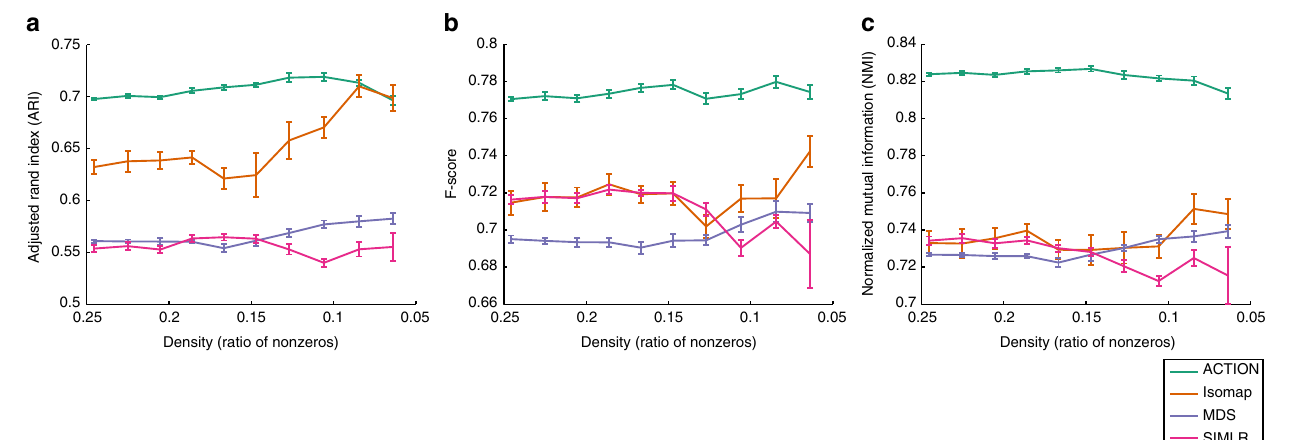
Fig. 4 ACTION Kernel Robustness. A series of expression pro fi les with varying degrees of dropout has been simulated from the CellLines dataset. In each case, we compute different metrics and use kernel k-means to identify cell types. The quality of cell-type identi fi cation is assessed with respect to known annotation from the original paper using three different extrinsic measures: a Adjusted Rand Index (ARI), b F-score, and c Normalized Mutual Information (NMI). These results show that ACTION and MDS have the most stable performance over dropout. Error bars correspond to repeated samples of